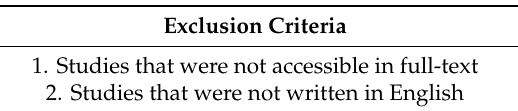
Table 2. Exclusion Criteria (second phase).